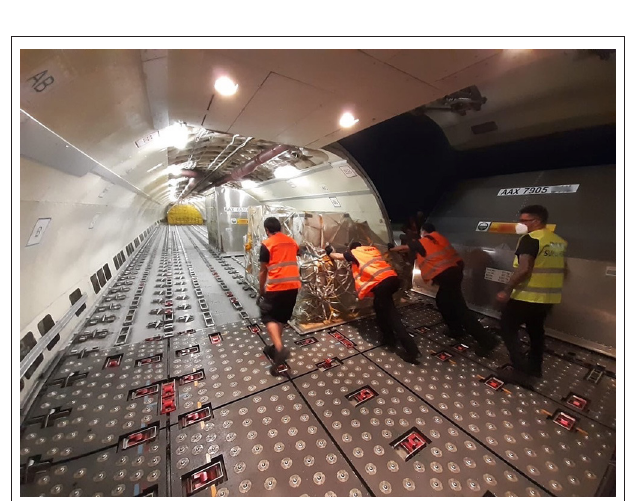
FIGURE 2 | The unit load device (ULD) is pushed by the operators inside the upper deck of a Cargo Aircraft.